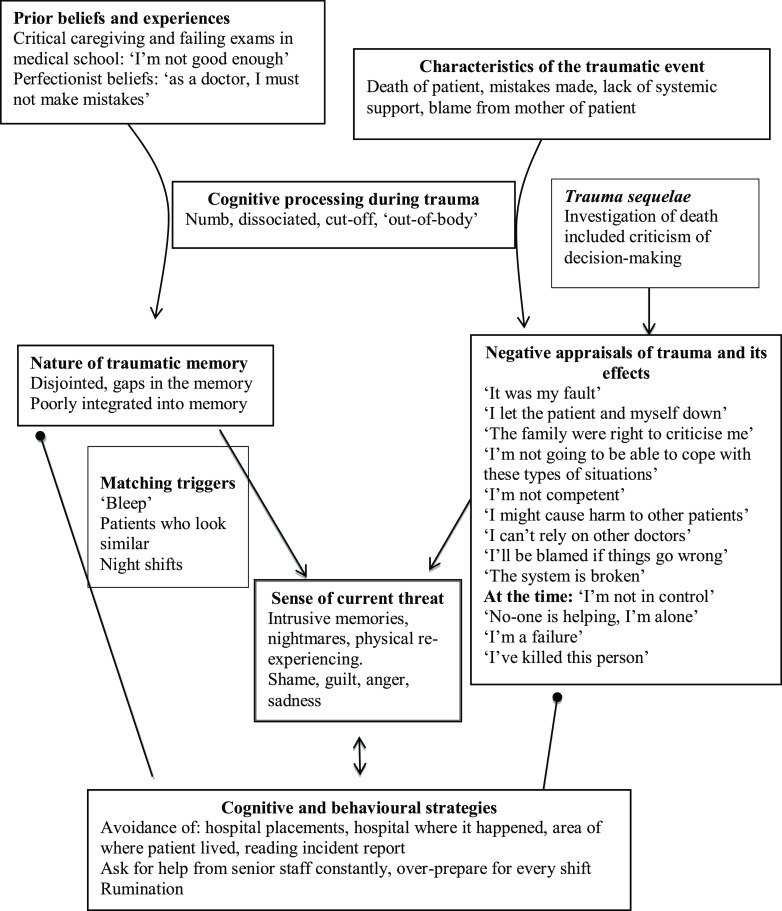
Tania’s formulation.